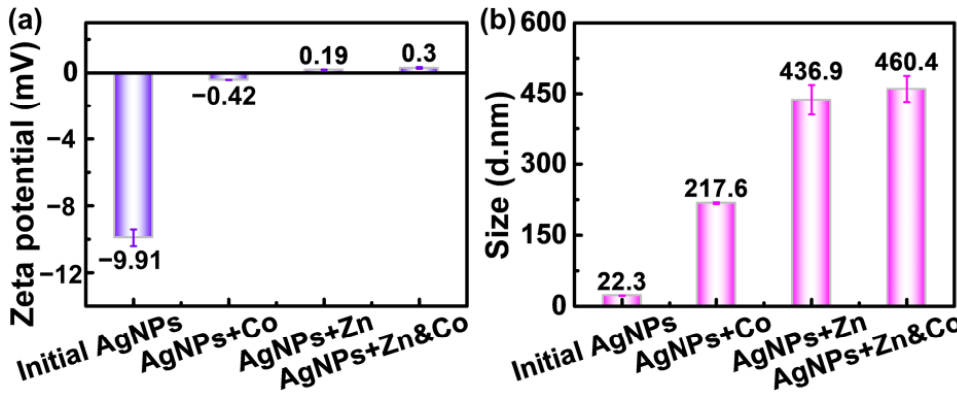
Figure 7. Zeta potential ( a ) and dynamic light scattering ( b ) of PVP-AgNPs before and after the addition of Co 2+ , Zn 2+ , and mixed solution of Co 2+ and Zn 2+ . [Co 2+ ] = 2 mg/L, [Zn 2+ ] = 50 g/L.